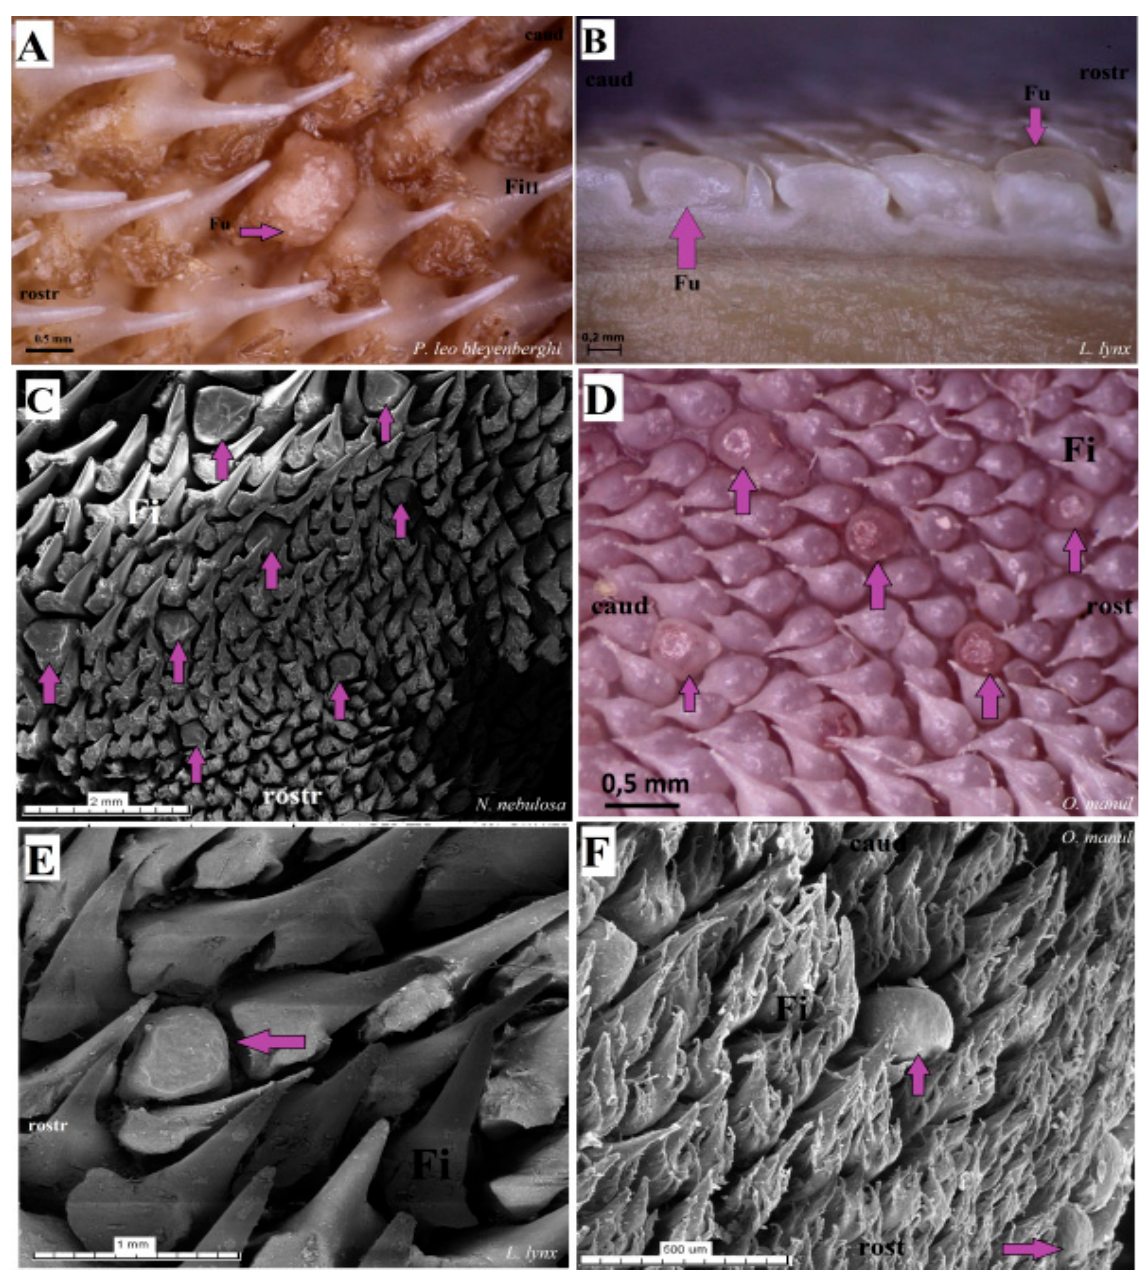
Figure 17. Macroscopic view ( A , B , D ) and scanning electron microscopy (SEM) ( C , E , F ) pictures of the fungiform papillae of the undomesticated species of Felidae. ( A ) Dorsal view of the one dome-shaped fungiform papilla (purple arrow) of the P. leo bleyenberghi with several filiform papillae. ( B ) Longitudinal section of the body of the tongue of L. lynx with well-visible sunken-shaped fungiform papillae between filiform papillae. ( C ) Eight sunken-shaped fungiform papillae within the filiform papillae on the dorsal surface of the body of tongue of N. nebulosa . ( D ) Five round-shaped fungiform papillae of the tongue of O. manul . ( E ) SEM picture of the one sunken-shaped fungiform papillae of the tongue of L. lynx . ( F ) Structure of the two smooth dome-shaped fungiform papillae of O. manul SEM. Bar = 2 mm (C); bar = 1 mm (E); bar = 0.5 mm (A,D,F); bar = 0.2 mm (B). Abbreviations: caud—caudal orientation of the filiform papillae, Fi — filiform papilla, Fu—fungiform papilla (purple arrow), rostr—rostral orientation of the filiform papillae.